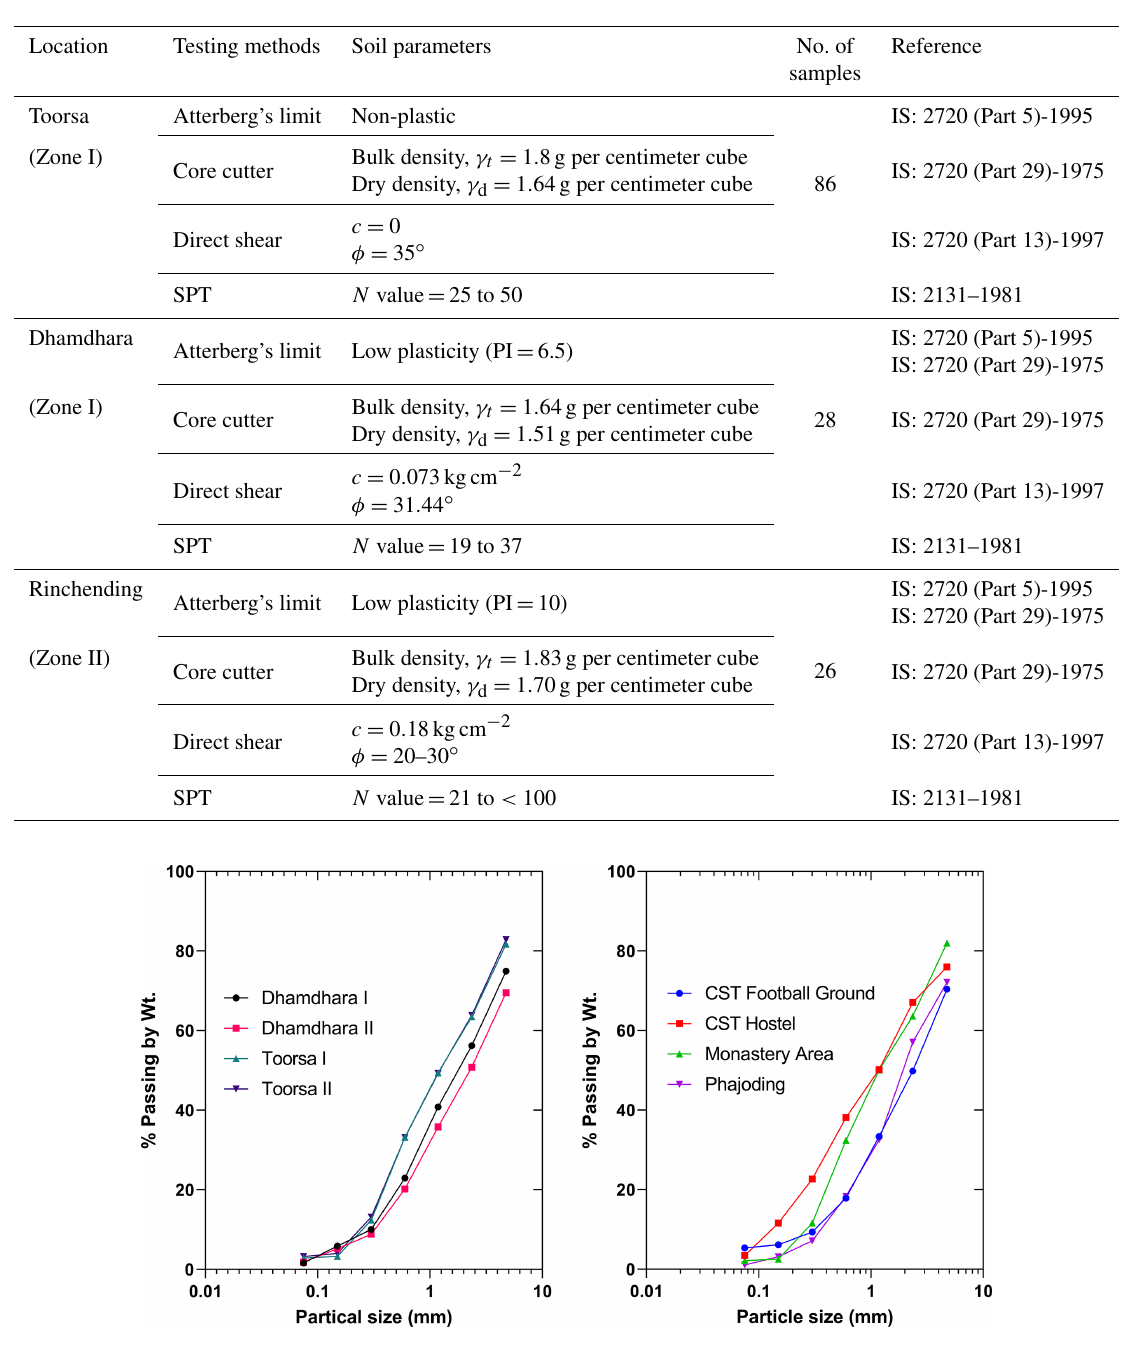
Figure 3. Representative grain size distribution curve for the study area.